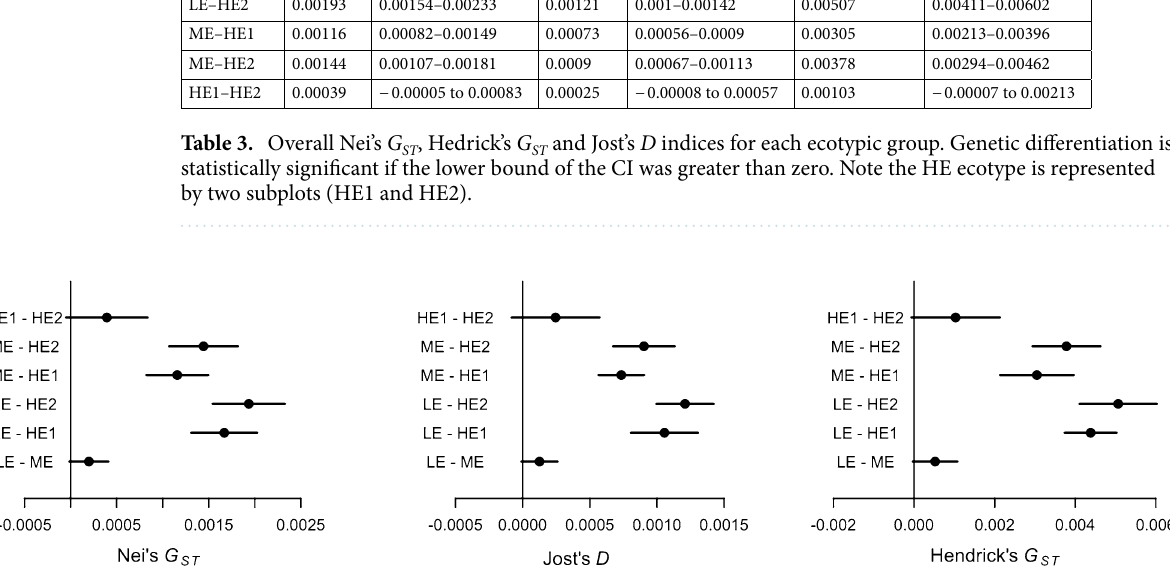
Figure 5. Pairwise genetic differentiation indices among Norway spruce populations. The observed values displayed with normalized 95% confidence